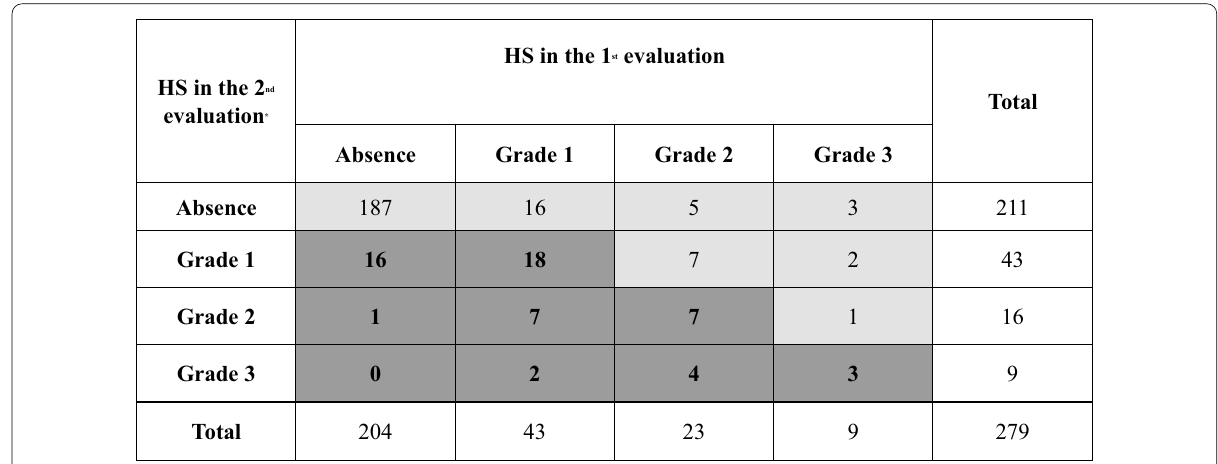
Fig. 1 Progression of hepatic steatosis (HS) in both evaluations. *Favorable progression (in light gray, n steatosis or improved the degree of steatosis. Unfavorable progression (in dark gray, n worsened the degree of